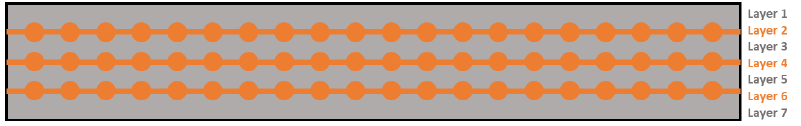
Figure 4. Composite layer distribution.